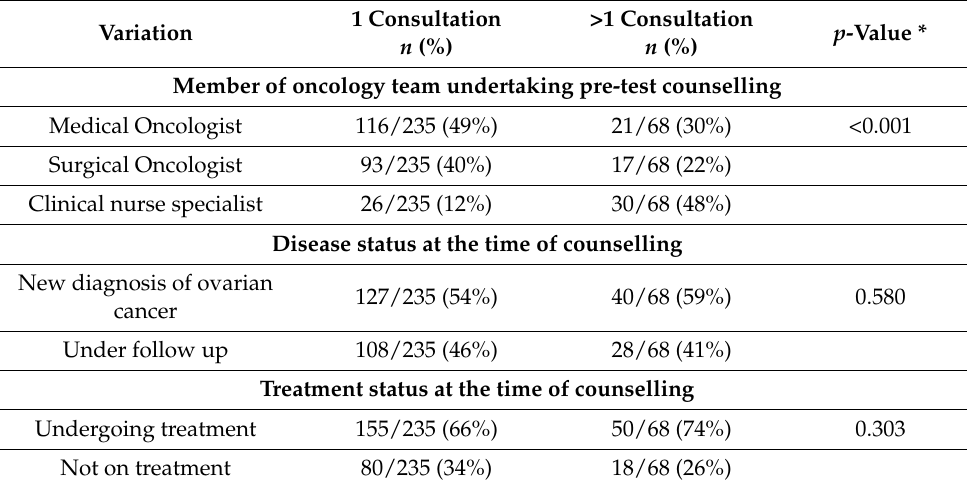
Table 1. Factors associated with number of pre-test